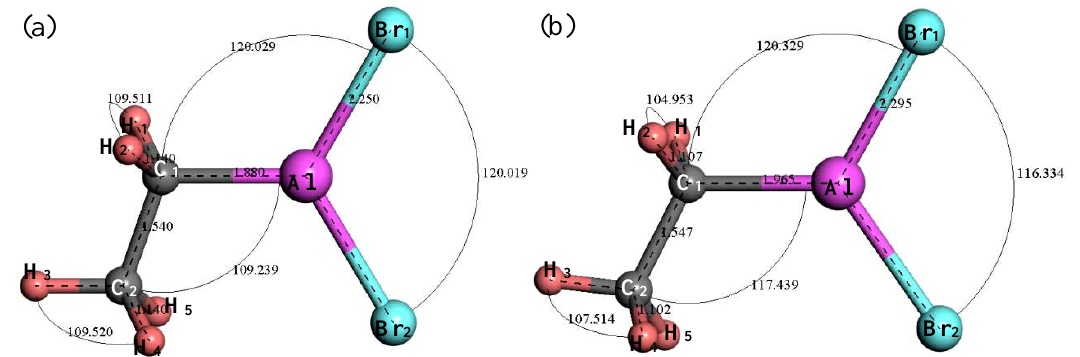
Figure 6. Molecular model of C 2 H 5 AlBr 2 molecule. ( a ) Initial model; ( b ) Optimized model. The unit of the angle in the image is (°), and the unit of the bond length is angstrom (Å).